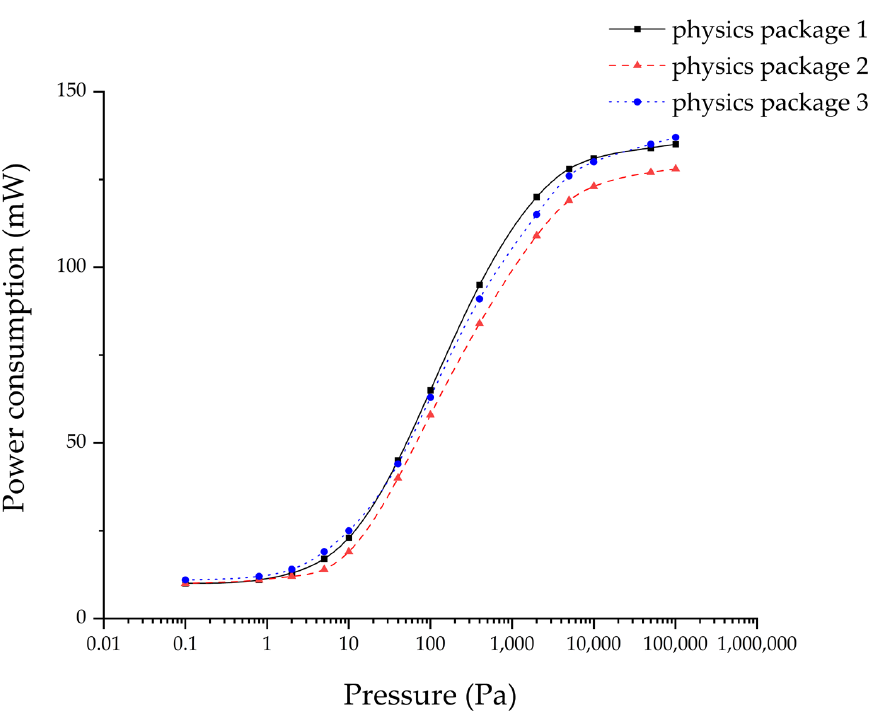
Figure 5. Electric power consumption of physics packages depending on cavity gas pressure when the VCSEL is ovenized to 85 °C .